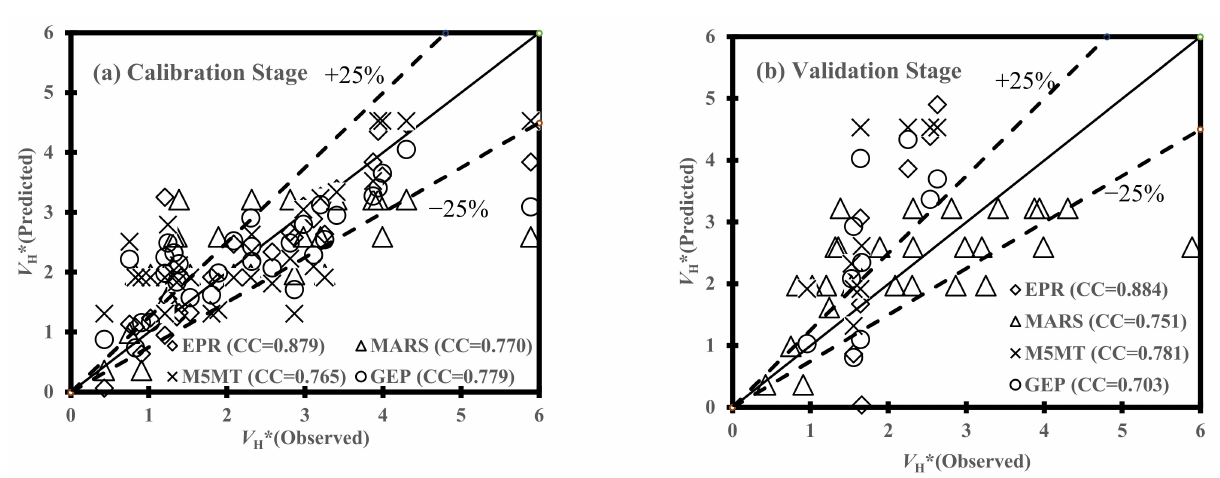
Figure 3. Performance of soft computing models in the prediction of V H * for ( a ) calibration and ( b ) validation